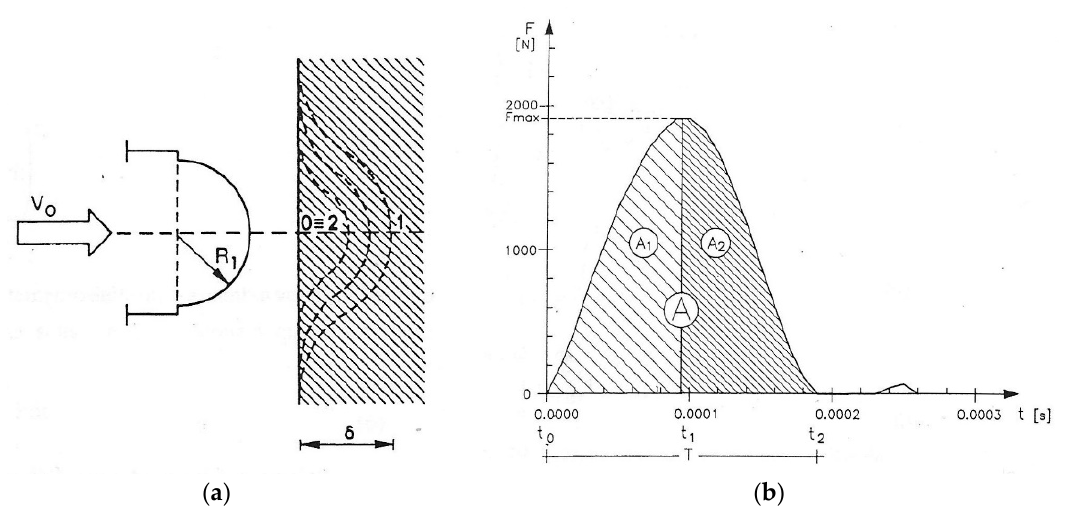
Figure 6. ( a ) Geometry of the mobile mass; ( b ) force–time curve obtained from an impact